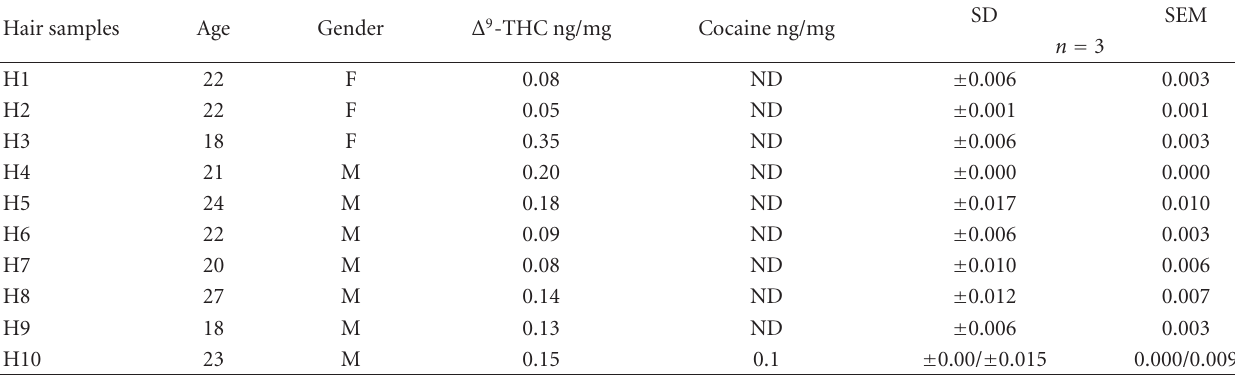
Table 2: Hair analysis results of samples using